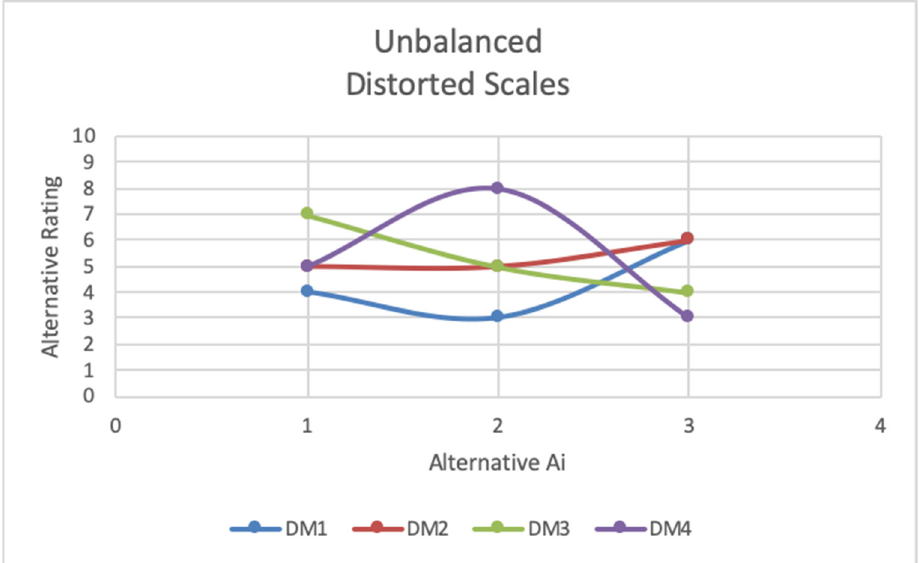
Figure 11. Case #18 unbalanced distorted scale (extreme bias).